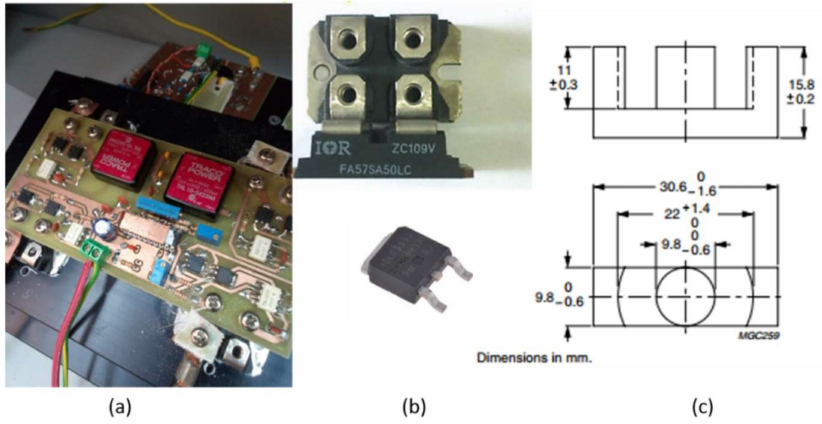
Figure 9. ( a ) Power stage, suitable for mains operation; ( b ) different switches; ( c ) core dimensions for the